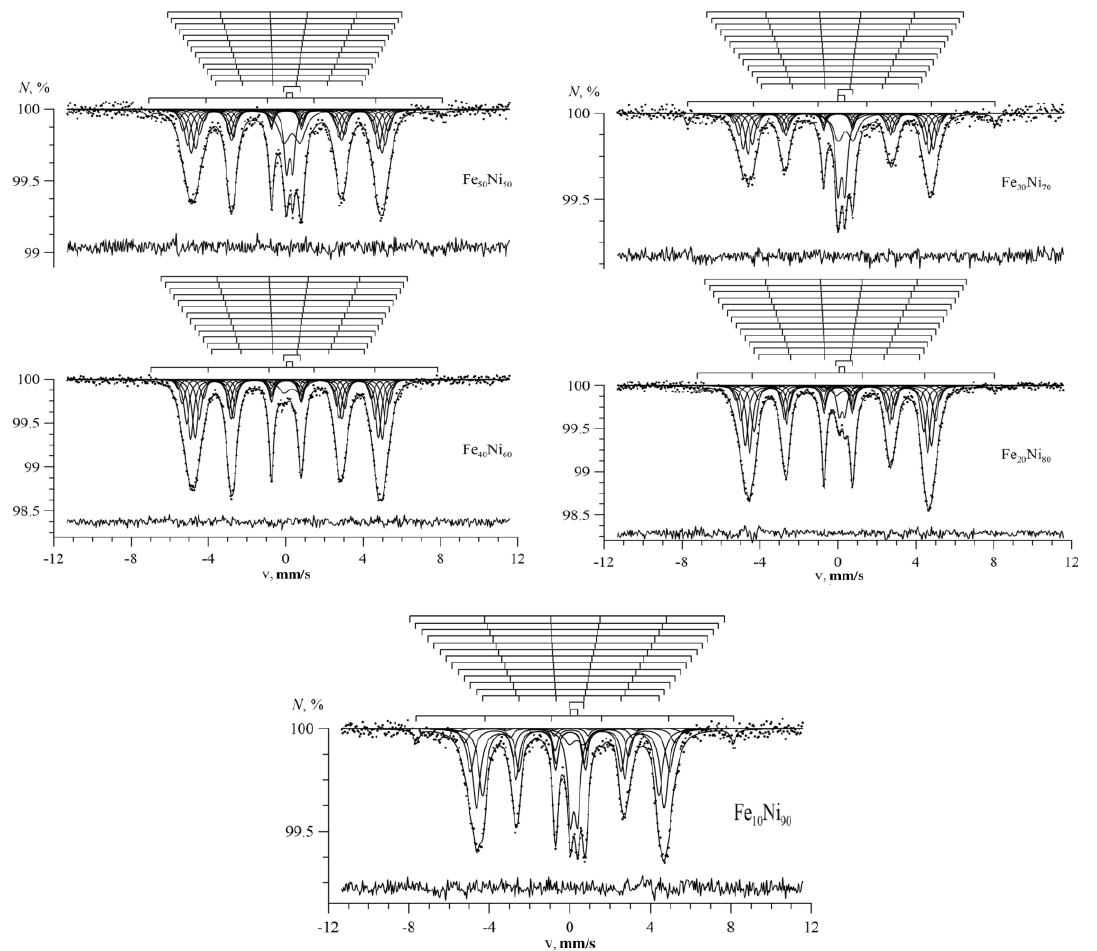
Figure 10. The result of the model decoding of the Mössbauer spectrum of Fe 100-x Ni x nanotubes.